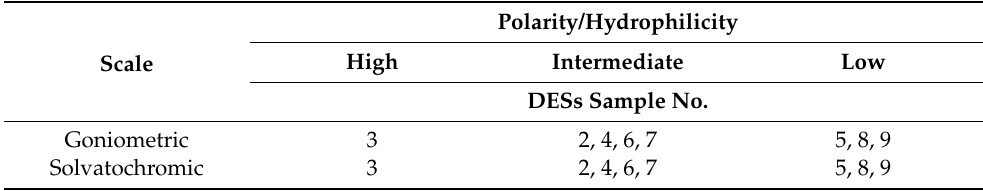
Table 3. Classification of DESs samples in terms of